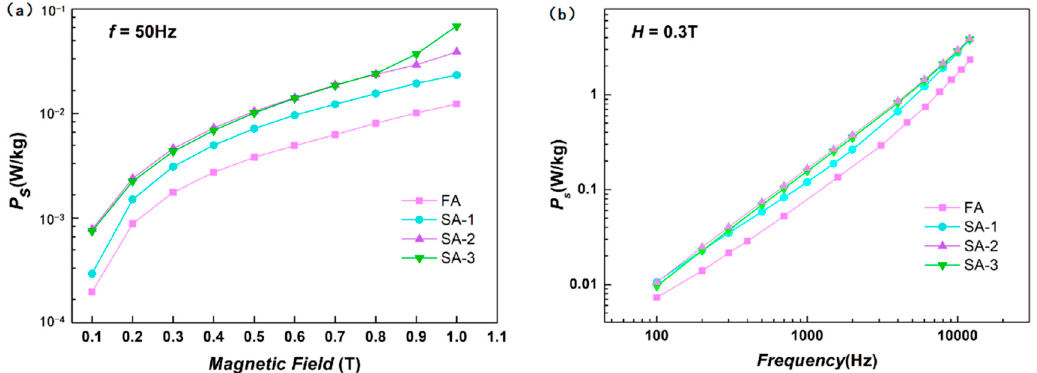
7 of 9 Figure 6. Frequency dependency of coefficient of inductance (effective permeability) in annealed samples. The reason for the observation of lower permeability in stress-annealed samples is that a transverse magnetic anisotropy is induced in the nanocrystalline alloy after stress annealing, and, consequently, it becomes difficult to magnetize the alloy in the direction of the magnetization field and the magnetic permeability is diminished [29]. Therefore, magnetic permeability of nanocrystalline cores can be tuned over a wide frequency range by stress annealing treatments during crystallization [1]. This is the distinct advantage of nanocrystalline soft magnetic alloys over the conventional gapped ferrite cores in which the control of inductance is confined by the fixed core geometry [30]. 3.6. Core Losses in Treated Samples The AC core loss ( P s ) for annealed samples is shown in Figure 7. It can be seen from Figure 7a that the P s in all samples increases as the strength of the magnetic field increases, mainly because more immense energy is required for the magnetic core to provide an increase in induction near the saturation [1]. The P s also increases with increasing frequency in all samples (see Figure 7b), due to eddy current losses at higher frequencies and the dynamic motions of the magnetic domain walls [2]. In the case of stress-annealed samples, the values of P s at constant frequency (Figure 7a) or constant